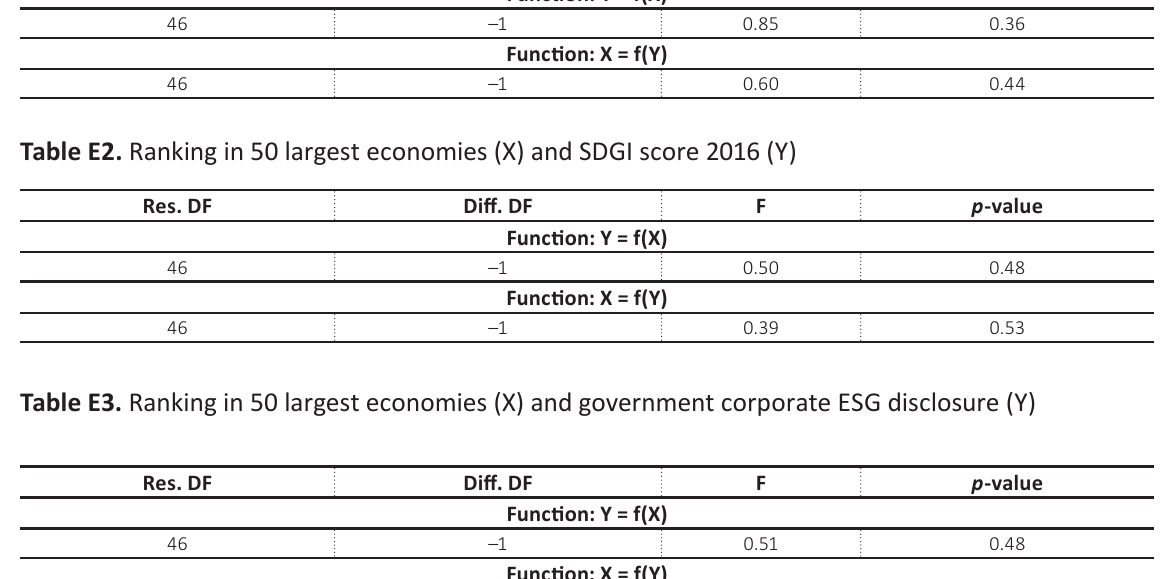
Table E1. Ranking in 50 largest economies (X) and SDGI rank 2016 (Y) Res. DF